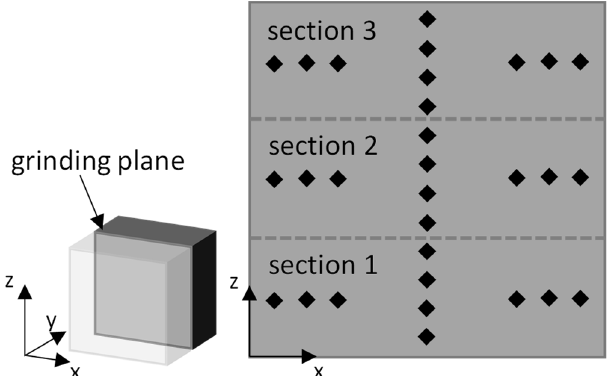
Figure 3. Illustration of the measurement positions to determine the hardness at different locations in the samples.